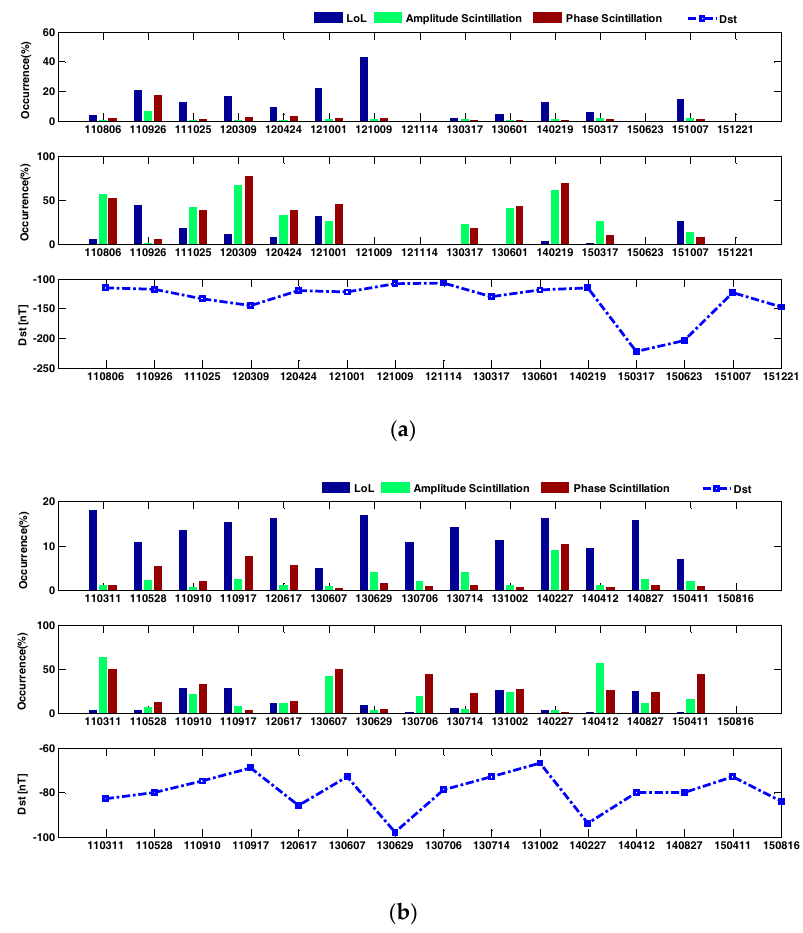
Figure 8. Loss of lock percentage towards geomagnetic storm group A ( a ) geomagnetic storm group B ( b ) from 2011 to 2015. Sensors 2017 , 17 , 2205